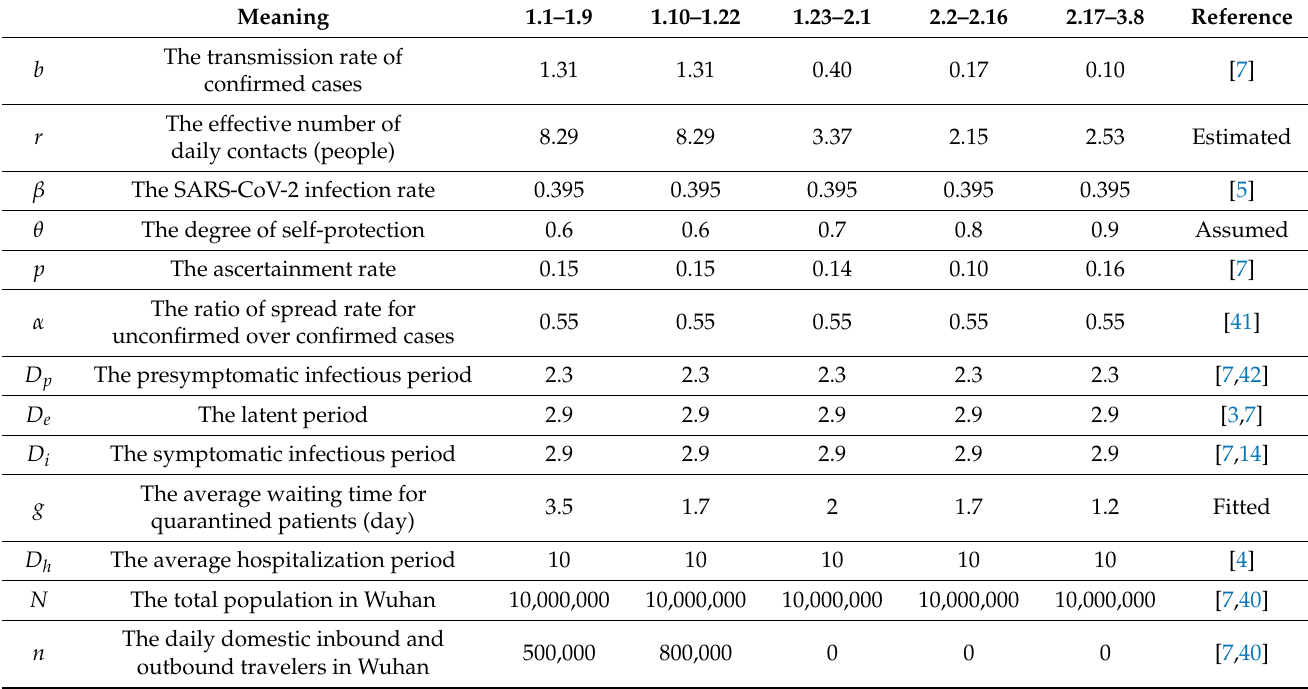
Table 1. Parameters of the infectious disease model in five